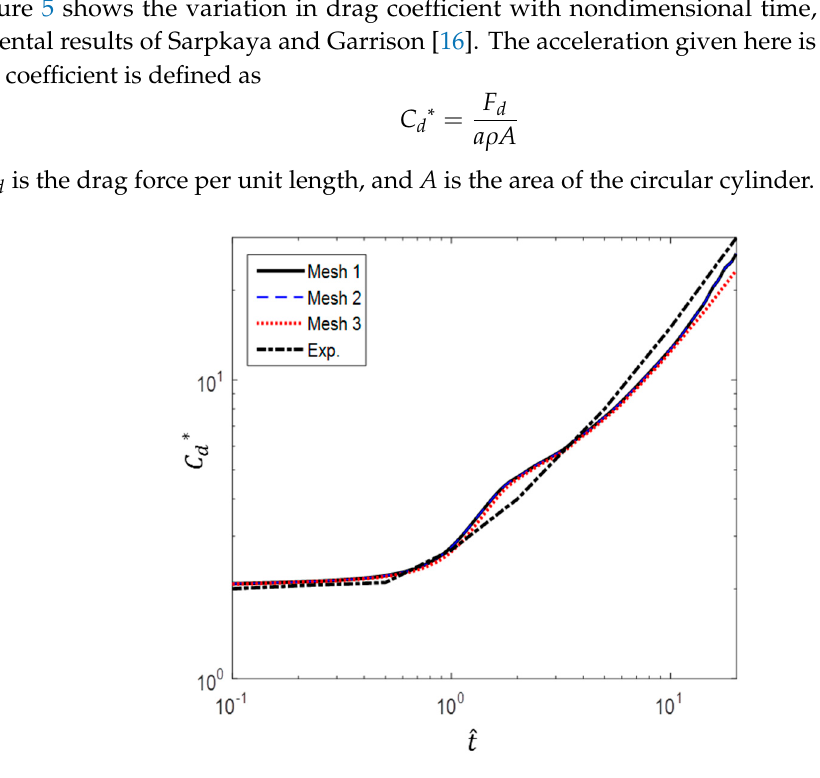
Figure 5. Comparison of different grid configurations (experimental data from Sarpkaya and Garrison [16])